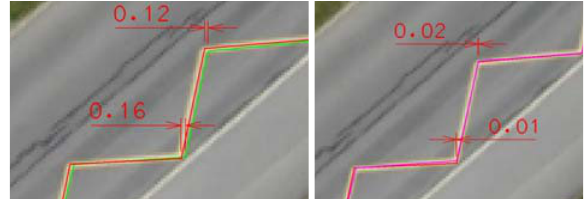
Figure 10: Comparison between feature lines. In Red, reference Orthophoto, in Green, Pix4D Orthophoto, in pink (right) SocetSet orthophoto.